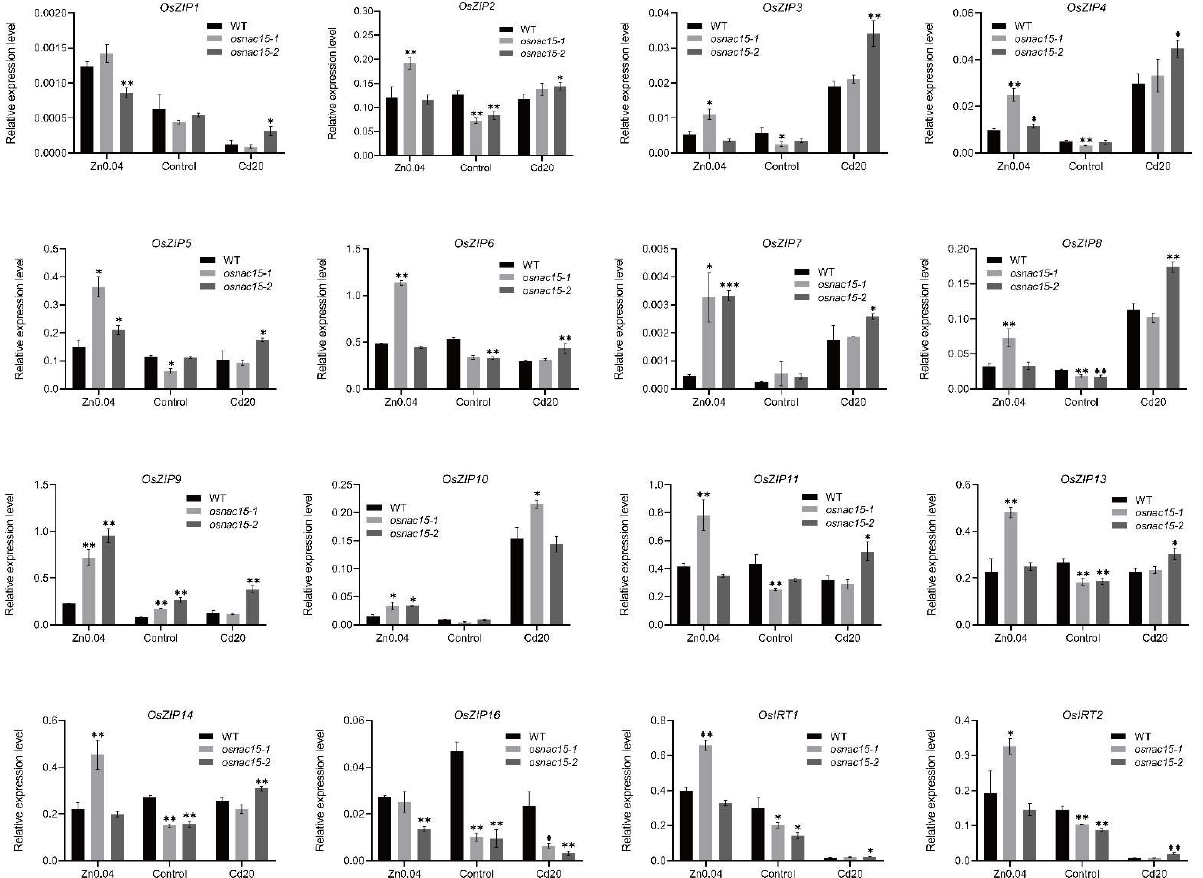
Figure 6. Expression of rice ZIP family genes in the WT and osnac15 mutants under Zn deficiency and Cd stress conditions. The 10-day-old WT and osnac15 mutant seedlings were transferred to 1/2 Kimura B solution containing 0.04 µM, 0.4 µM ZnSO 4 or 20 µM CdCl 2 for 3 days. Total RNAs were extracted from the roots. Data are means ± SD of three biological replicates. * and ** indicate significant differences at p < 0.05 and 0.01, respectively, by Student’s t -test.